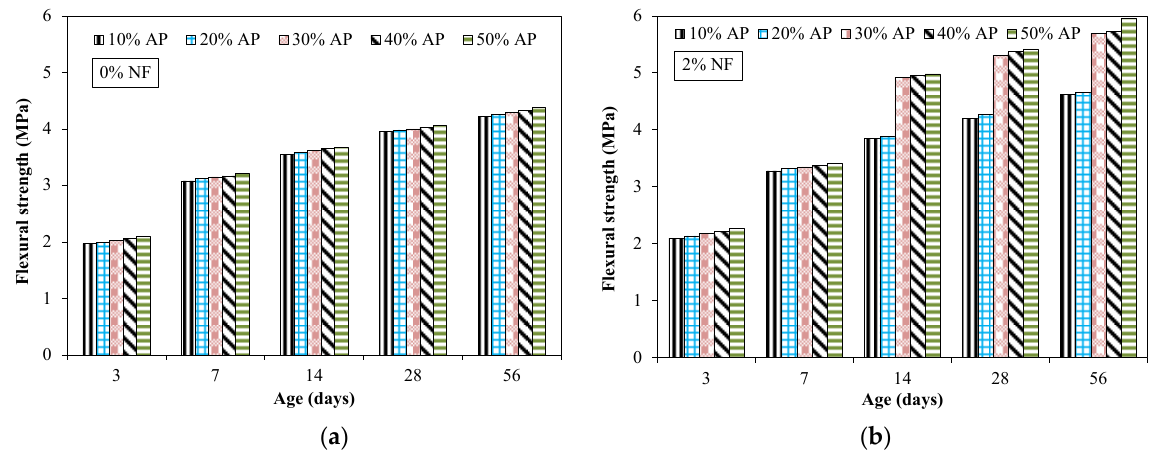
Figure 10. Flexural strength results for specimens incorporating AP and fibers. ( a ) 0% fibers. ( b ) 2% fibers. Table 6. Coefficient of variation for flexural strength